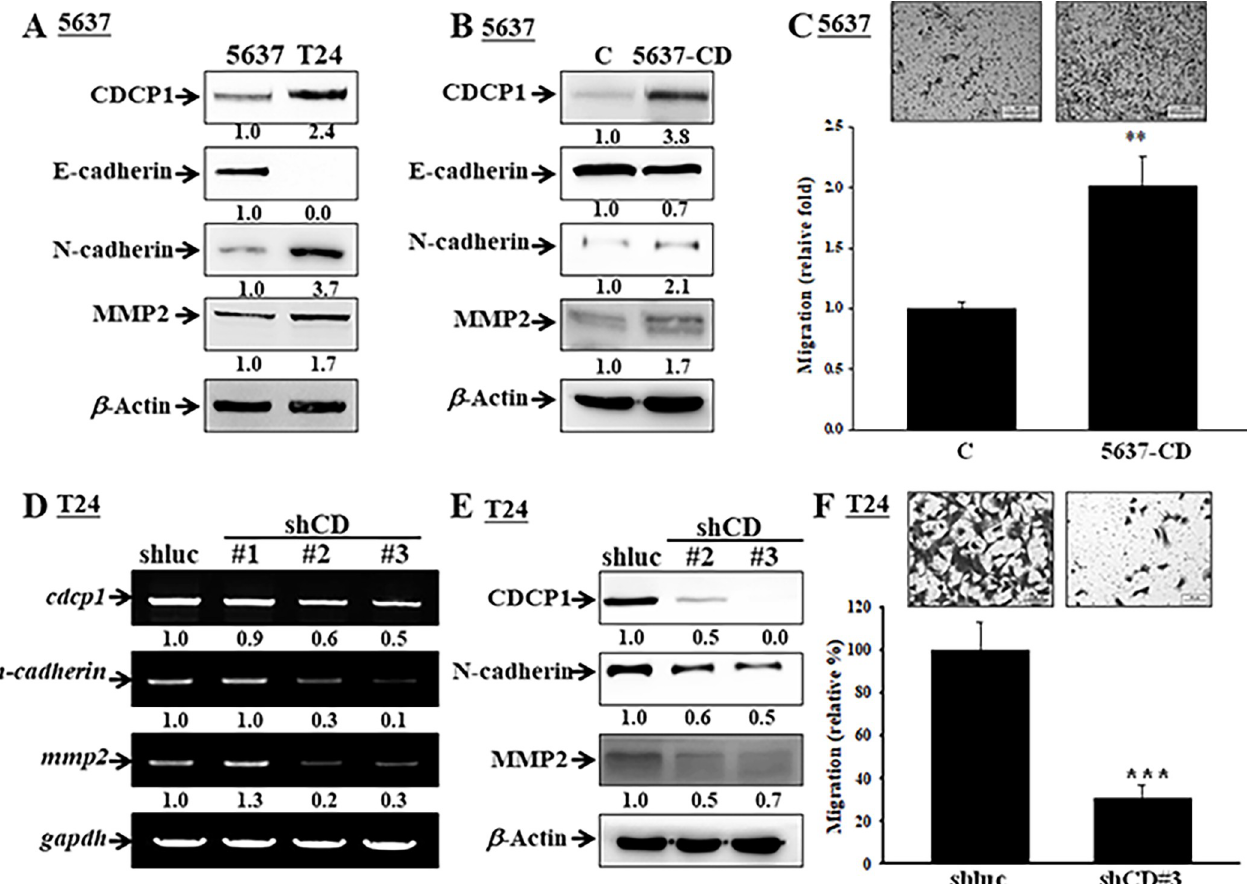
Fig 3. Effects of CDCP1 on the EMT markers alternation and cellular migration abilities in UC cells. Cell lysates were collected from (A) 5637 and T24 cells or from (B) parental and 5637-CD cells to perform Western blot for detecting CDCP1, n-cadherin, e-cadherin, MMP2, and β -actin. (C) Parental and 5637-CD cells were harvested to seed on the upper chamber of Transwell 1 , then the abilities of migration were measured as described in the “Materials and methods” section. Images of migration were taken at 200x magnification. Scale bar indicates 100 μ m. In addition, T24 cells were transfected the CDCP1 specific shRNA plasmids for 24 hrs, and then harvested for the detection of (D) mRNA level, or (E) protein level of EMT markers, respectively. (F) Besides, the migration abilities of CDCP1-silenced T24 cells and parental cells were measured as described in “Materials and methods” section. Images of migration were captured at 400x magnification. Scale bar indicates 50 μ m. Statistical analysis were analyzed by unpaired two-tailed Student’s t-test. The results were presented as mean ± SD (n = 3, � p < 0.05, �� p < 0.01, ��� p < 0.001).